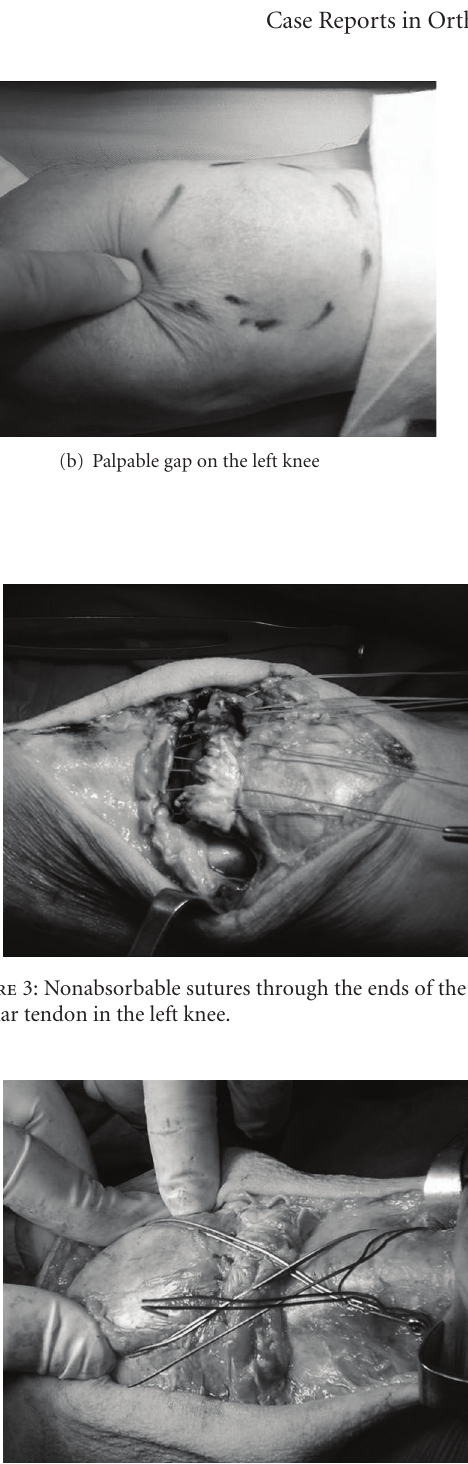
Figure 4: Tension band wire through tibial tuberosity for reinforc- ing the